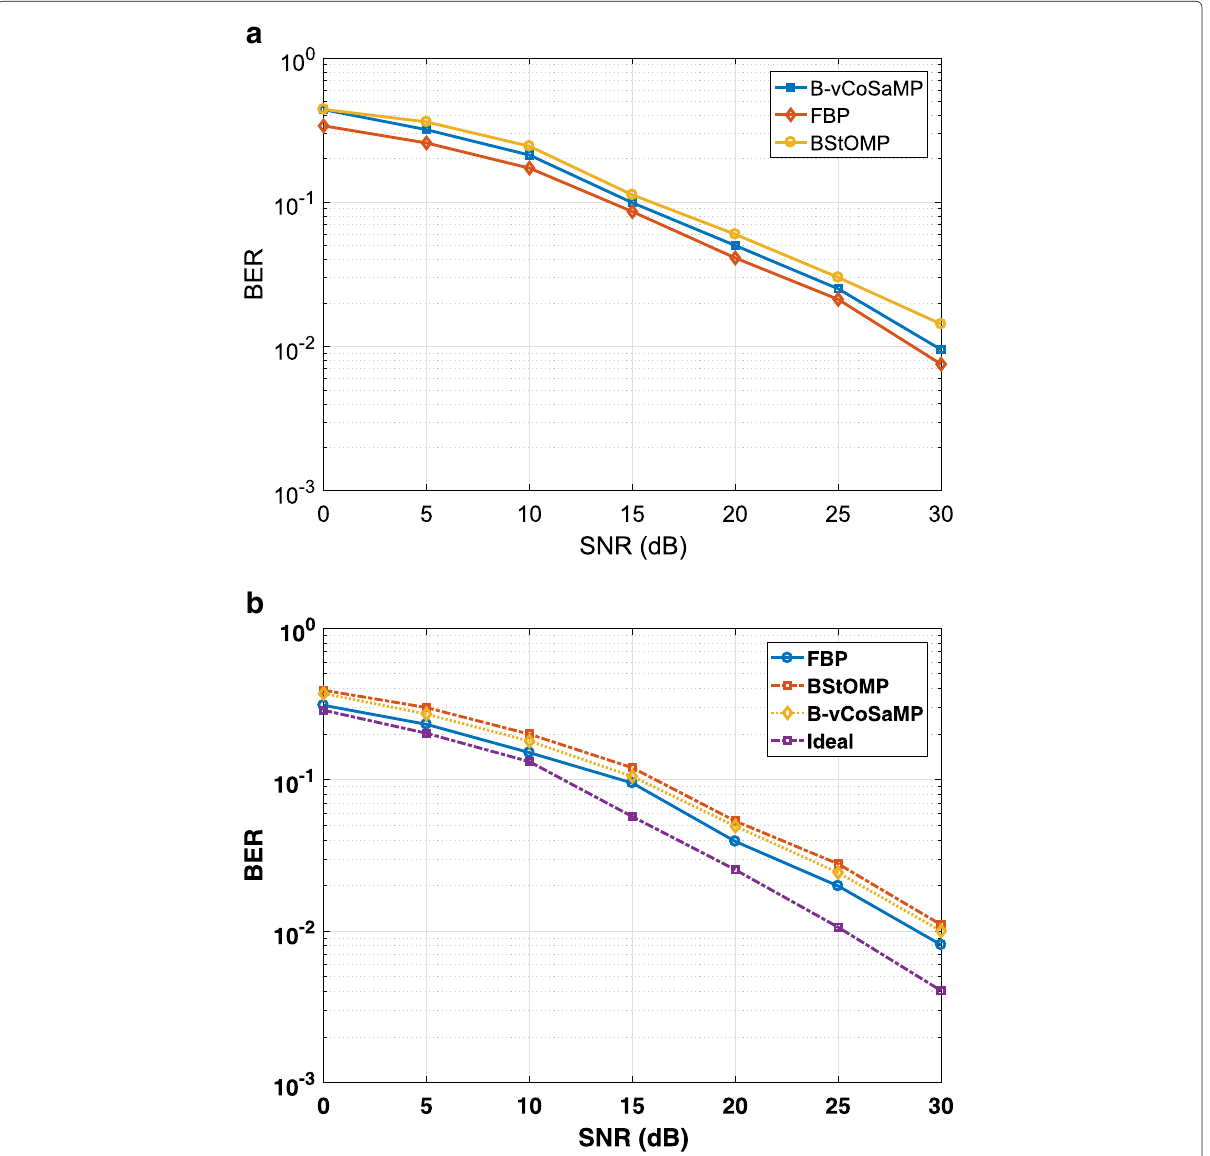
Fig. 2 Comparison of the proposed FBP-based method, B-vCoSaMP, and BStOMP: a MSE and b